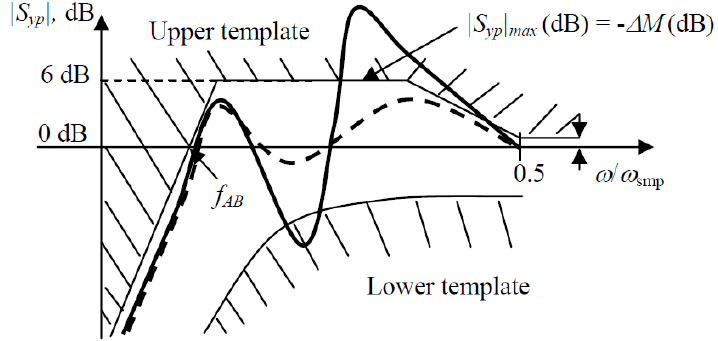
Figure 6. Template of the Bode magnitude diagram of the sensitivity function S